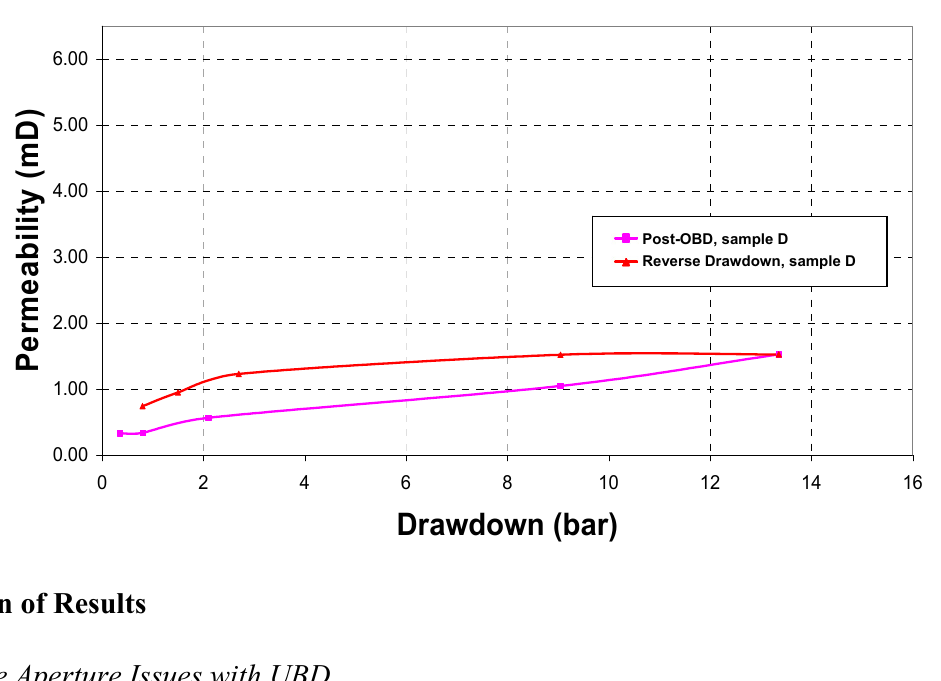
Figure 9. Hysteresis effect on sample